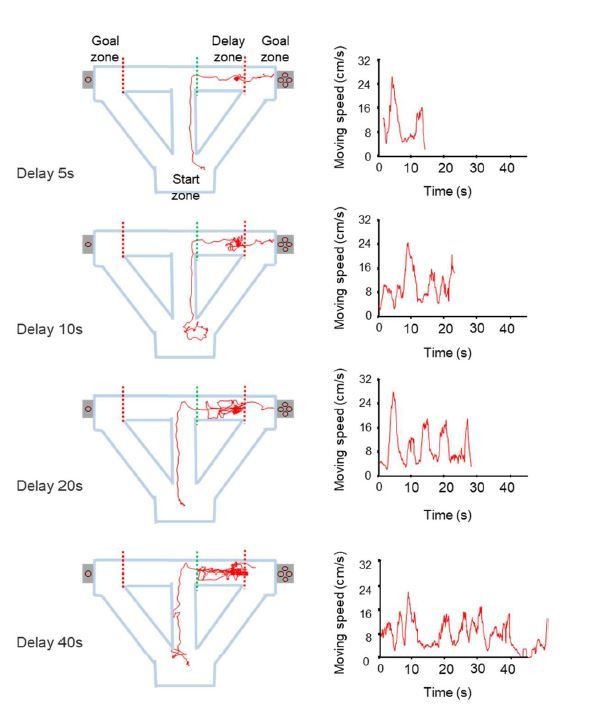
Moving patterns and speed during delay.Left: Moving traces of single trial on delay 5, 10, 20 and 40 s conditions. Right: Moving speed corresponding to the trials shown in the left traces. Initial high speed movements (around 20-24 cm/s) occurred by starting a trial are followed by constant intermitted speed movements (around 16 cm/s). Note that there is no obvious difference in moving speed among the delay 5, 10, 20 and 40 s conditions. Data from mouse M9.